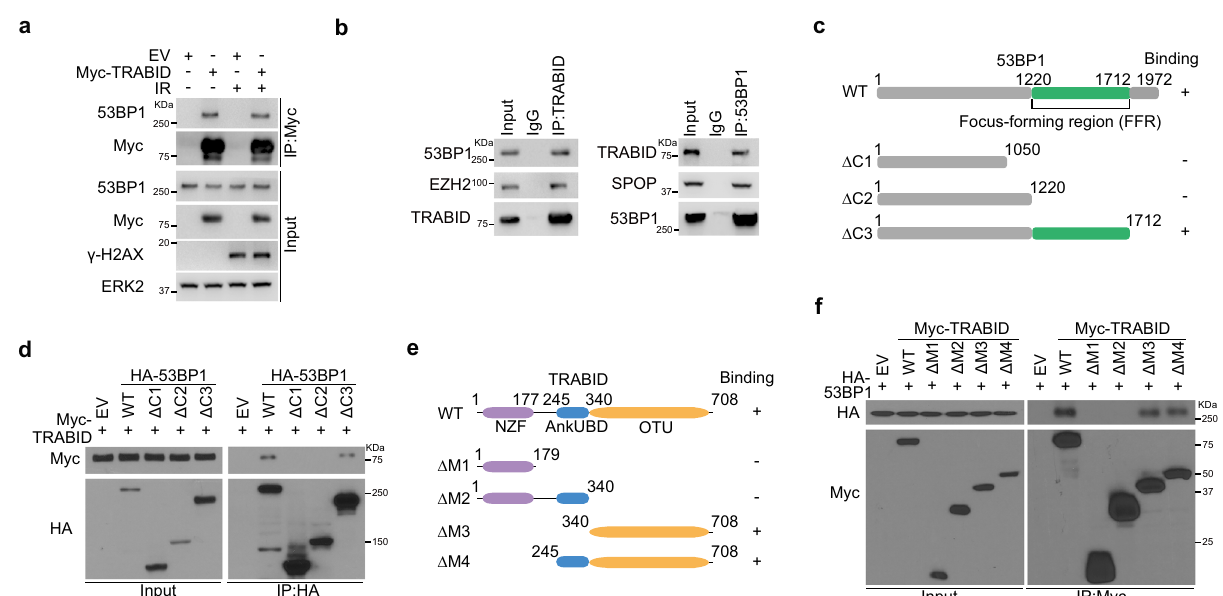
Fig. 2 | TRABID interacts with the focus-forming region of 53BP1. a 293T cells transfected with indicated plasmids were treated with IR for 1h, followed by co-IP and WB. ERK2 was used as a loading control. b Co-IP analysis of endogenous pro- teins in PC-3 cells using the indicated antibodies, EZH2 and SPOP were used as positivecontrolineachco-IP.IgGimmunoglobulinG. c Schematicof53BP1domain structure and expression constructs. d 293T cells transfected with indicated